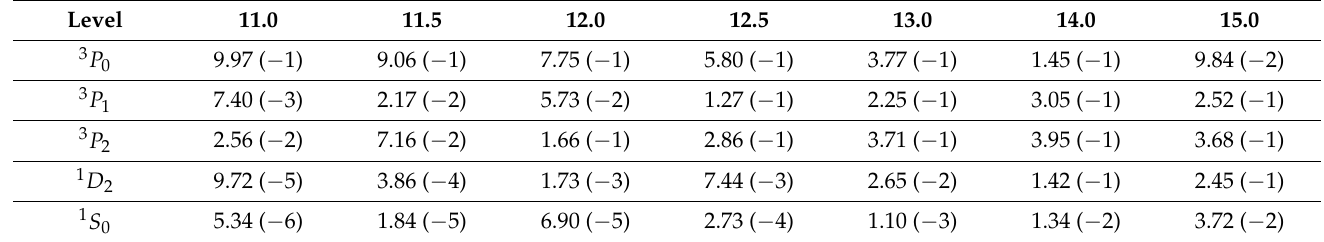
Table 6. Populations of levels in the ground configuration as a function electron